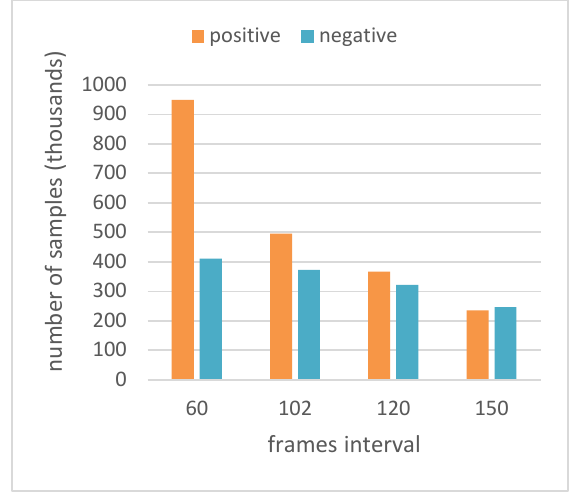
Figure 3. Comparison number of samples per class (first Table 1. Holonification model features.